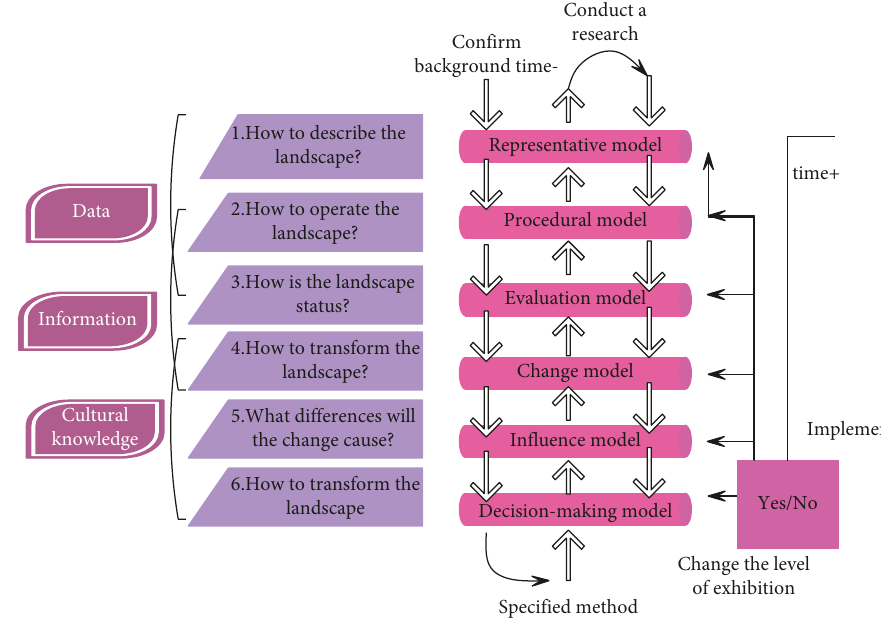
Figure 2: Landscape design